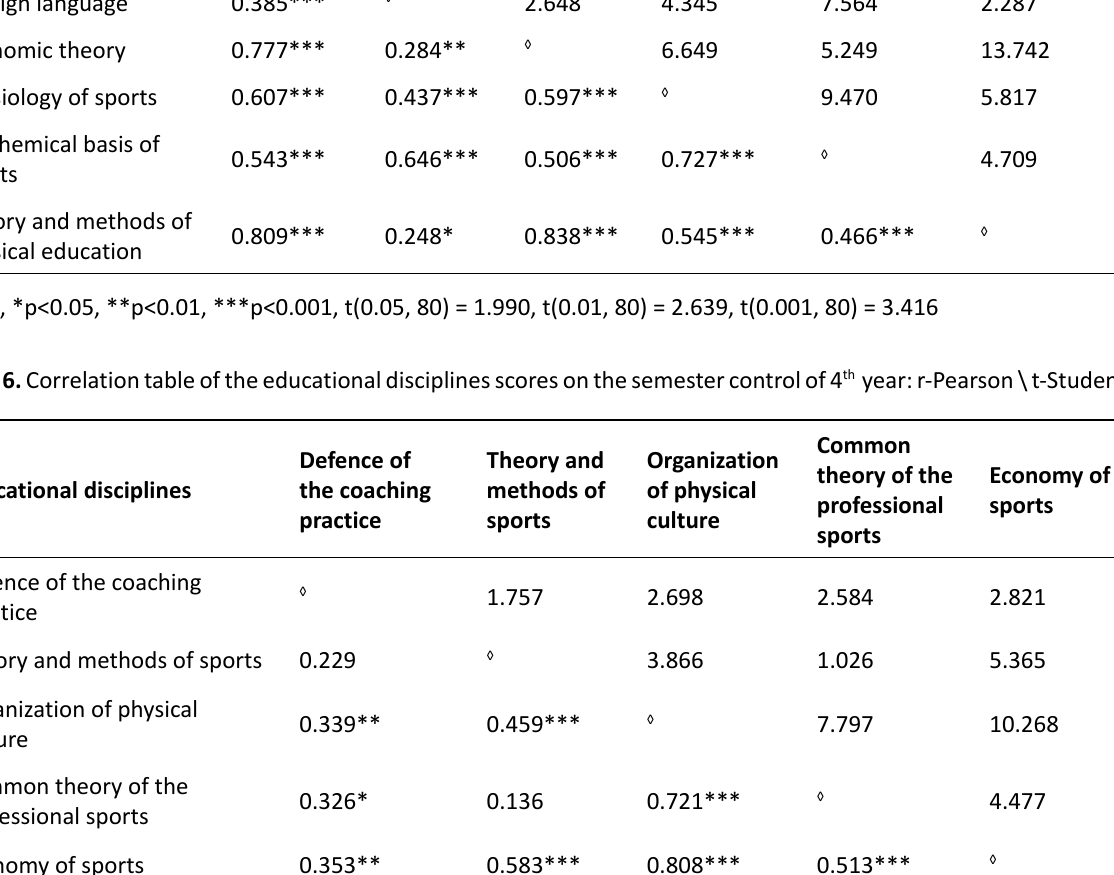
Educational disciplines